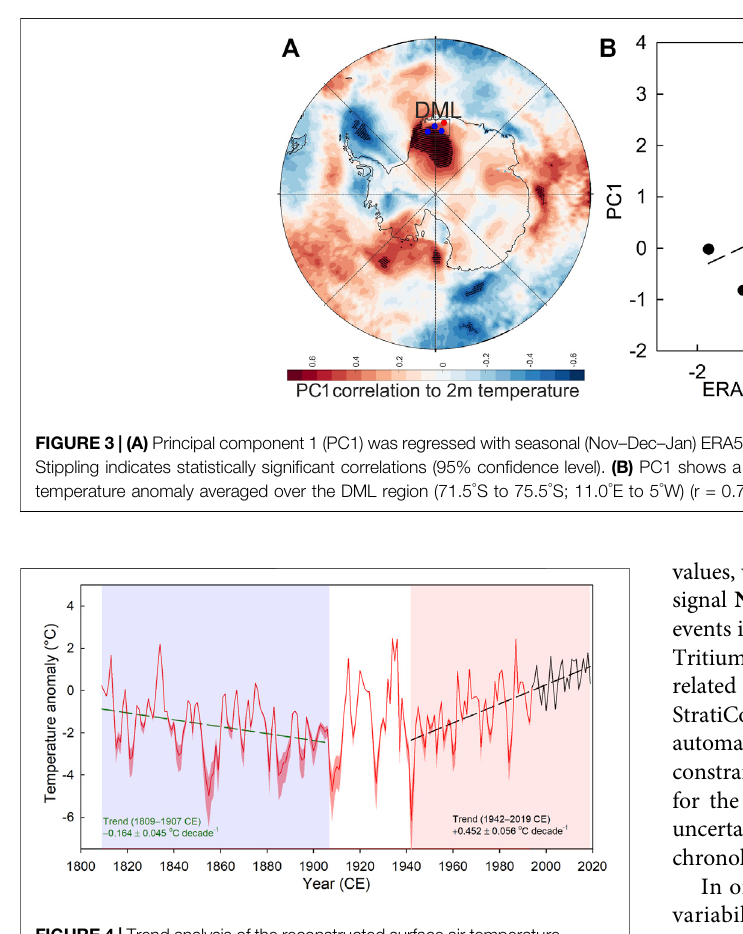
FIGURE 4 | Trend analysis of the reconstructed surface air temperature anomaly record ofthe DML region, East Antarctica. The temperature anomaly was calculated based on the linear regression equation derived from the correlation between PC1 and ERA5 temperature anomaly (NDJ). The reconstructed mean annual surface air temperature anomaly demonstrates a signi fi cant ( p < 0.05) declining trend during 1809 – 1907 CE and a signi fi cant ( p < 0.05) increasing trend during 1942 – 2019 CE. The reconstructed temperature anomaly curve is shown in the red line(1807 – 1993 CE), whereas the black curve denotes the ERA5 2m temperature anomaly record for 1994 – 2019 CE. The red color shade represents the error envelope on the reconstructed temperature, and the dashed straight lines indicate trend